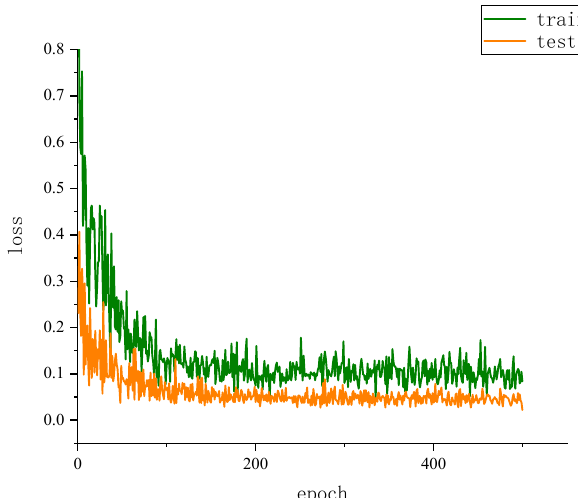
Figure 10. Training and testing of number of epochs.